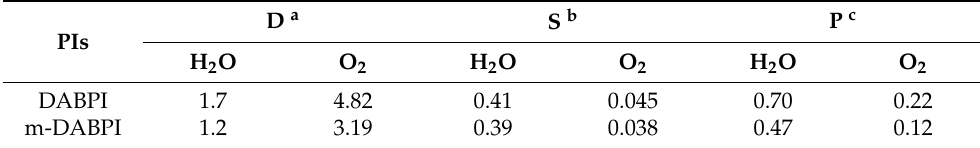
Table 5. Simulated diffusion coefficients (D), solubility coefficients (S), and permeability (P) for O 2 and H 2 O in DABPI and